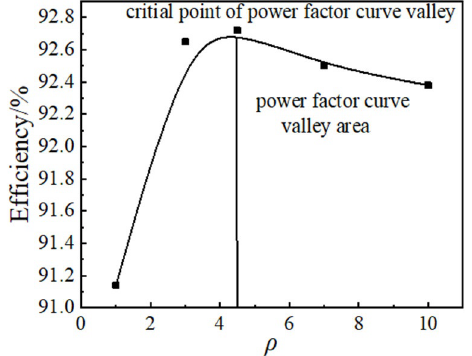
Figure 21. Efficiency curve with different ρ at λ = 0.8.